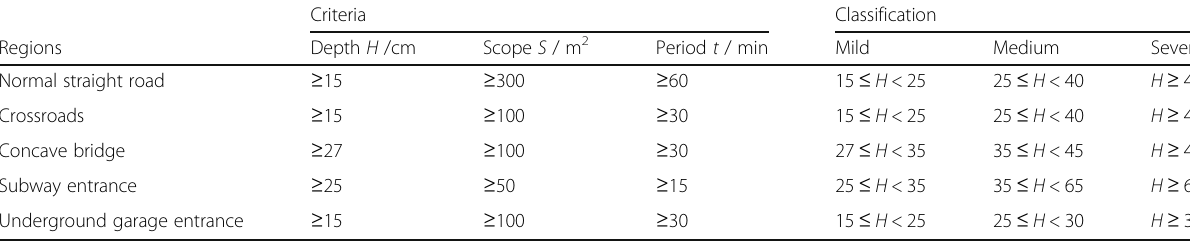
Table 1 Criteria and classification of urban waterlogging for typical regions [33]